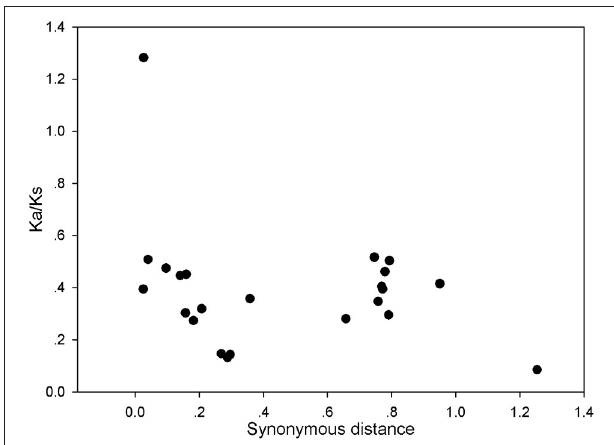
FIGURE 6 | Scatter plots of the Ka/Ks ratios of duplicated PRX genes in pear. X-axis represents the synonymous distance, and y-axis the Ka/Ks ratio for each pair, respectively.